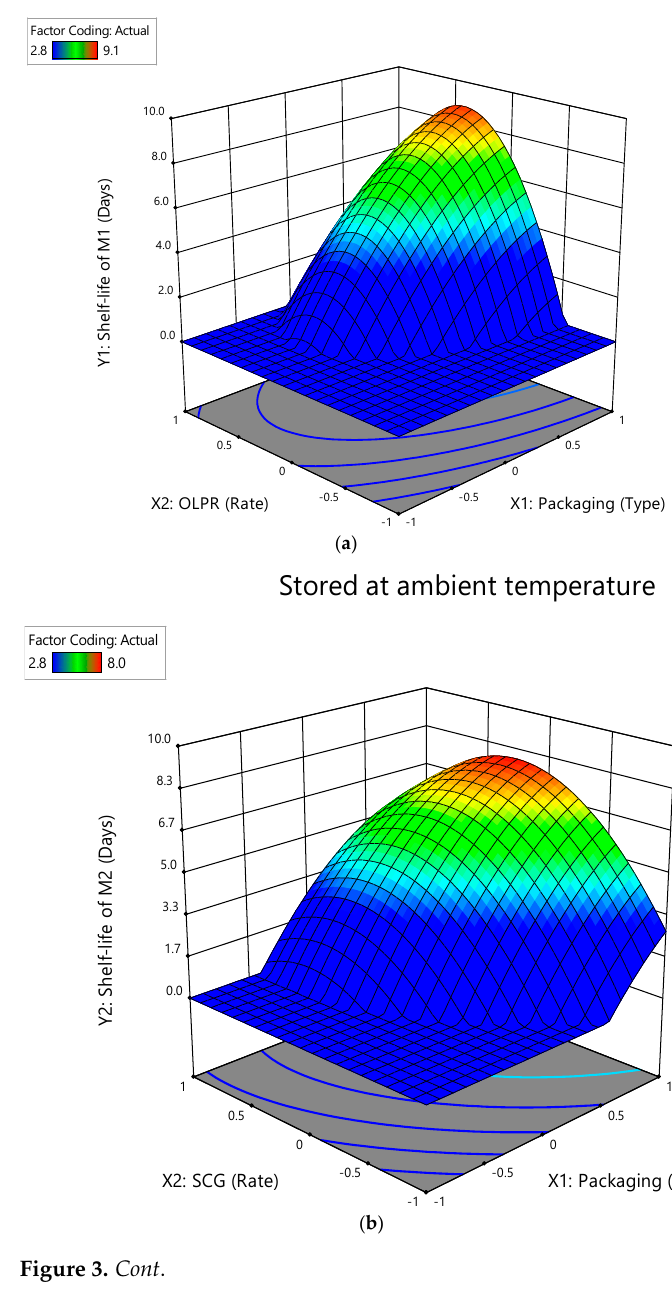
( c ) Figure 3. Three-dimensional surface plots for the interactive effect of packaging type and OLPR, SCG, and OLPR/SCG rates on shelf-life during storage at ambient temperature: ( a ) M 1 (mushrooms